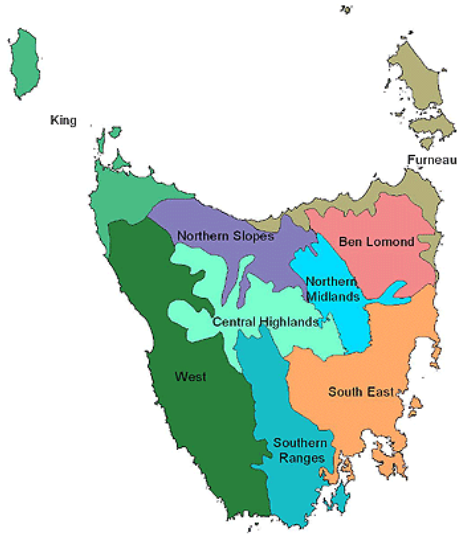
Figure 1. Nine bioregions of Tasmania. Source [49].